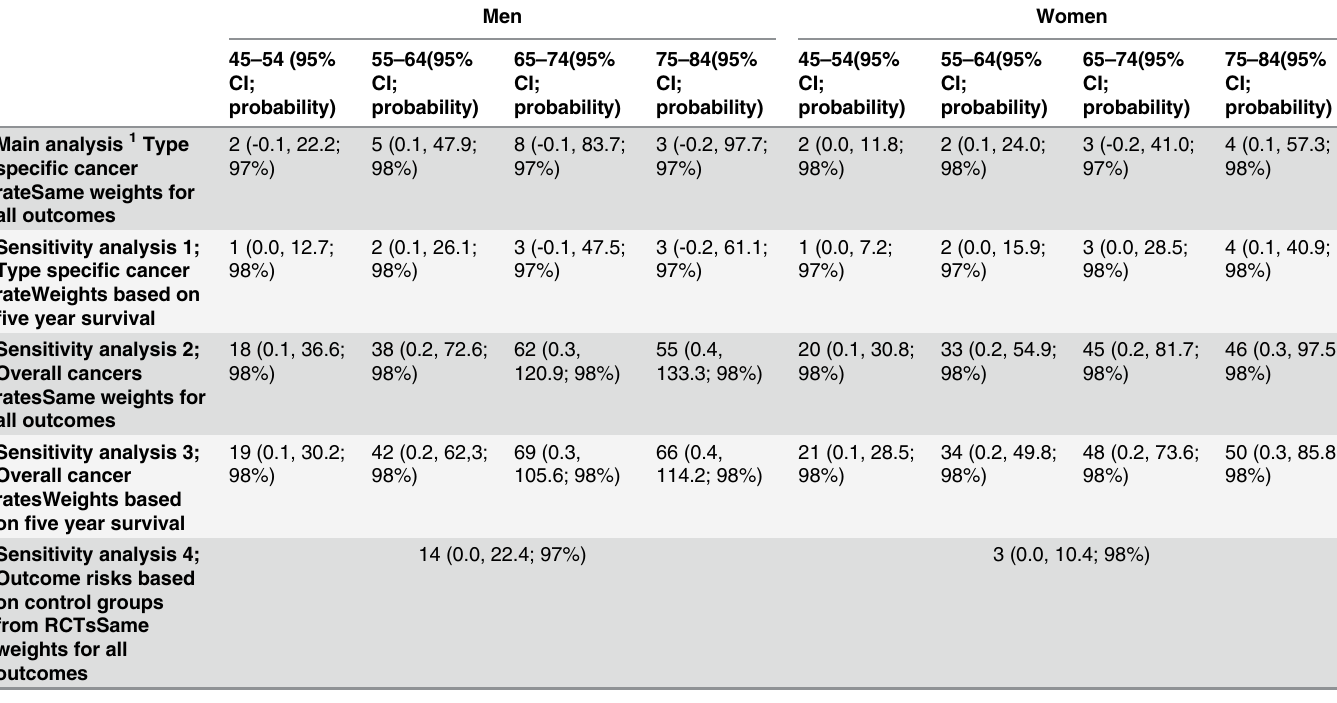
Table 4. Benefit-harms comparison index for primary prevention of cardiovascular events and cancer with low dose aspirin over 10 years per 1,000 persons (95% CI and probability that index is positive based on recalculating the index in